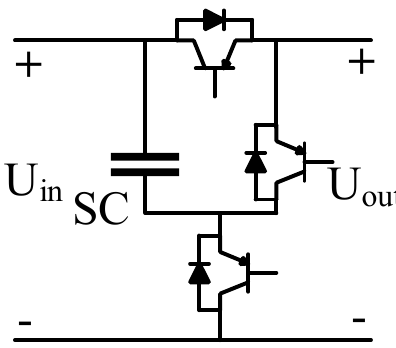
Figure 21. The Quasi-Z source converter topology with supercapacitor.